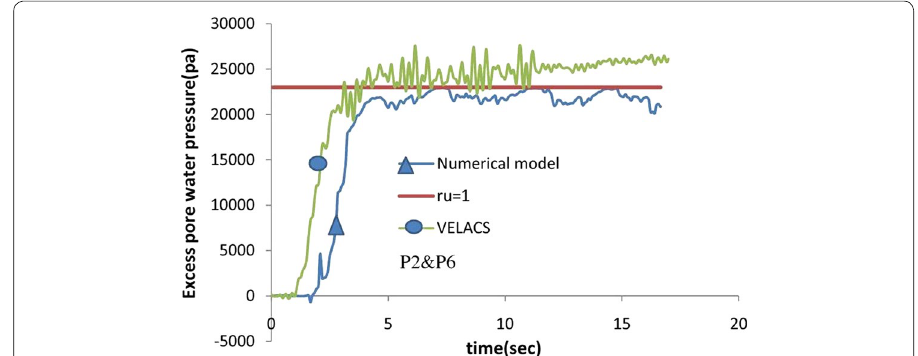
Fig. 5 Comparison of excess pore water pressure values at depth of 2.5 m